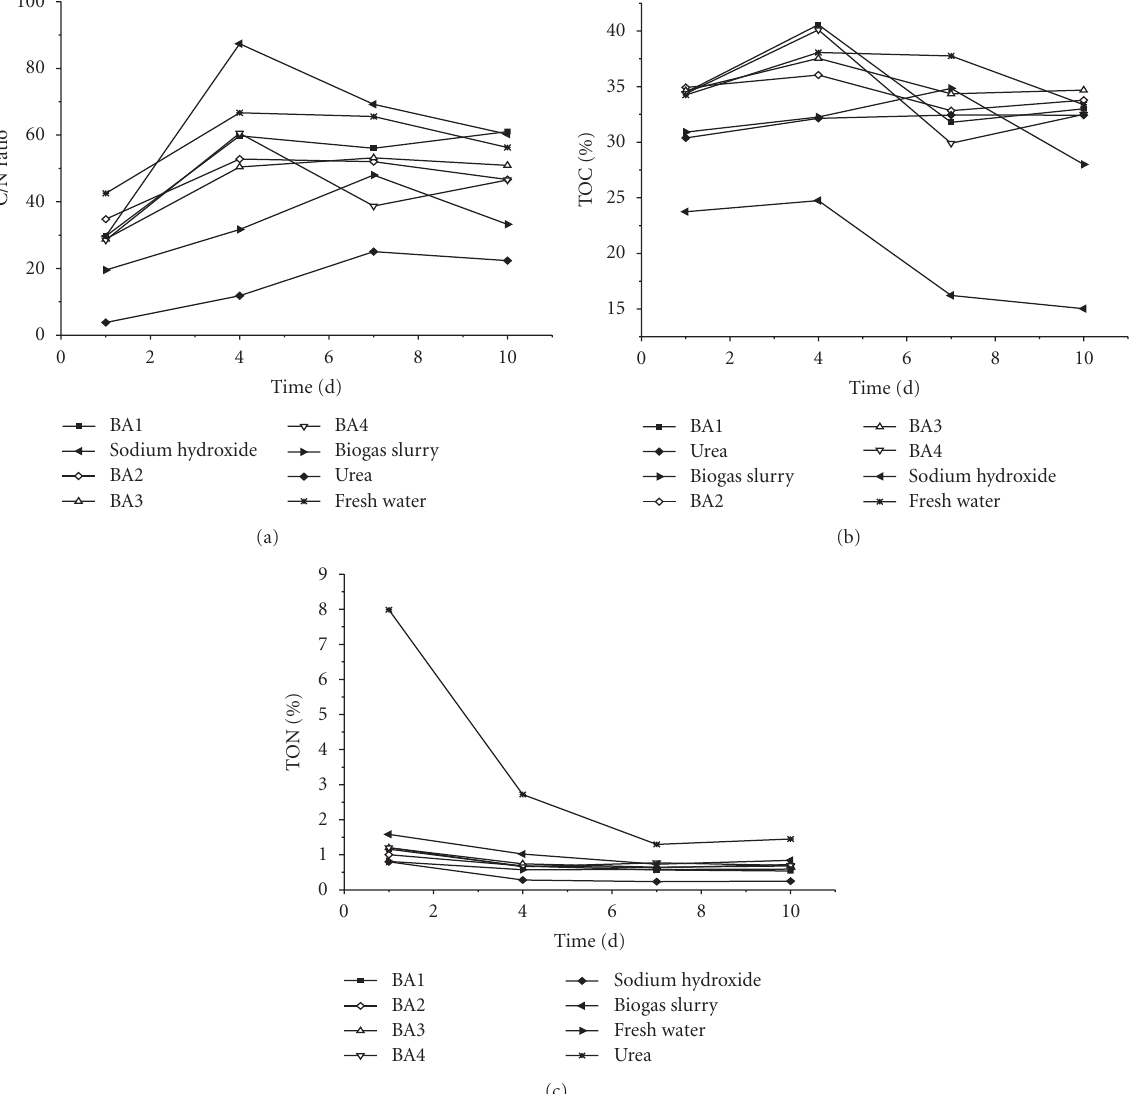
Figure 5: Changes in C/N ratio, TOC, and TON during the pretreatment process: (a) changes in C/N ratio, (b) changes in TOC, (c) changes in